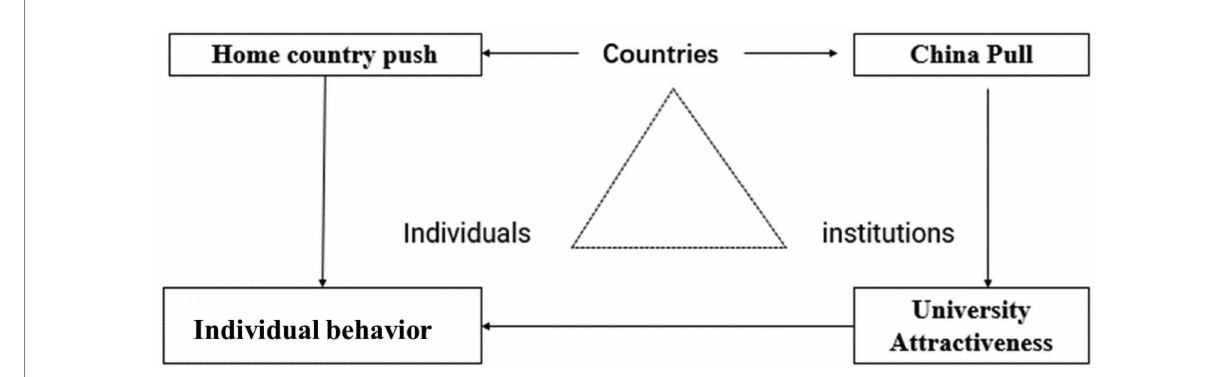
FIGURE 1 Framework for the analysis of international students’ university choices and influencing